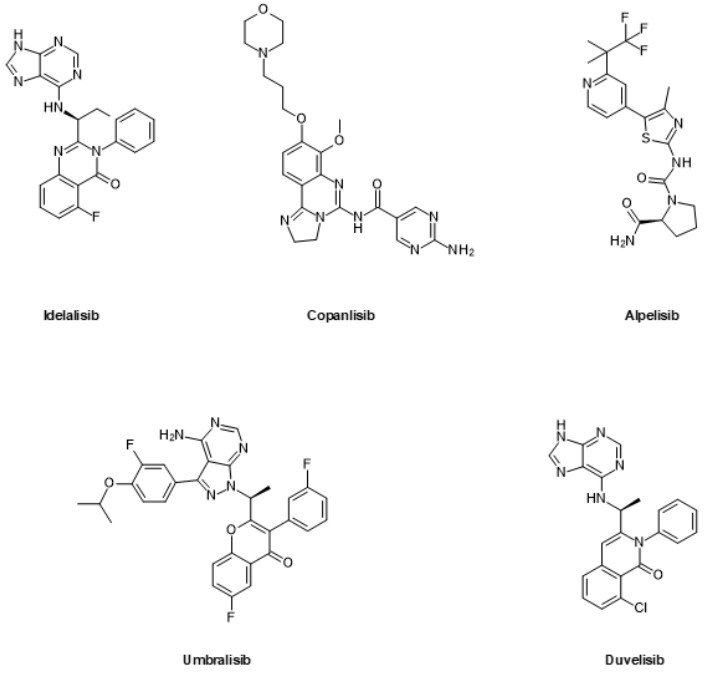
Figure 5. FDA-approved inhibitors of PI3K.